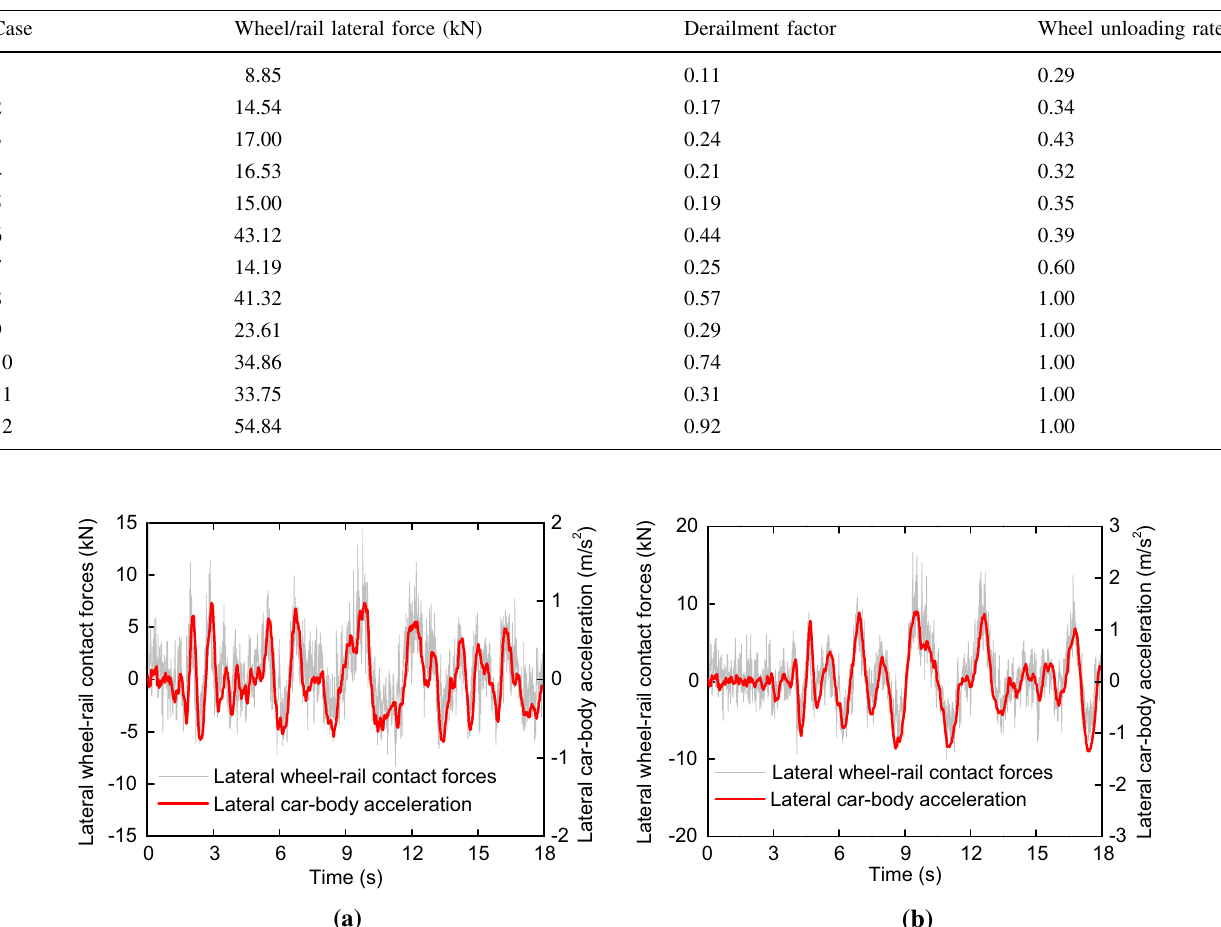
Table 4 Maximum running safety indices of all cases